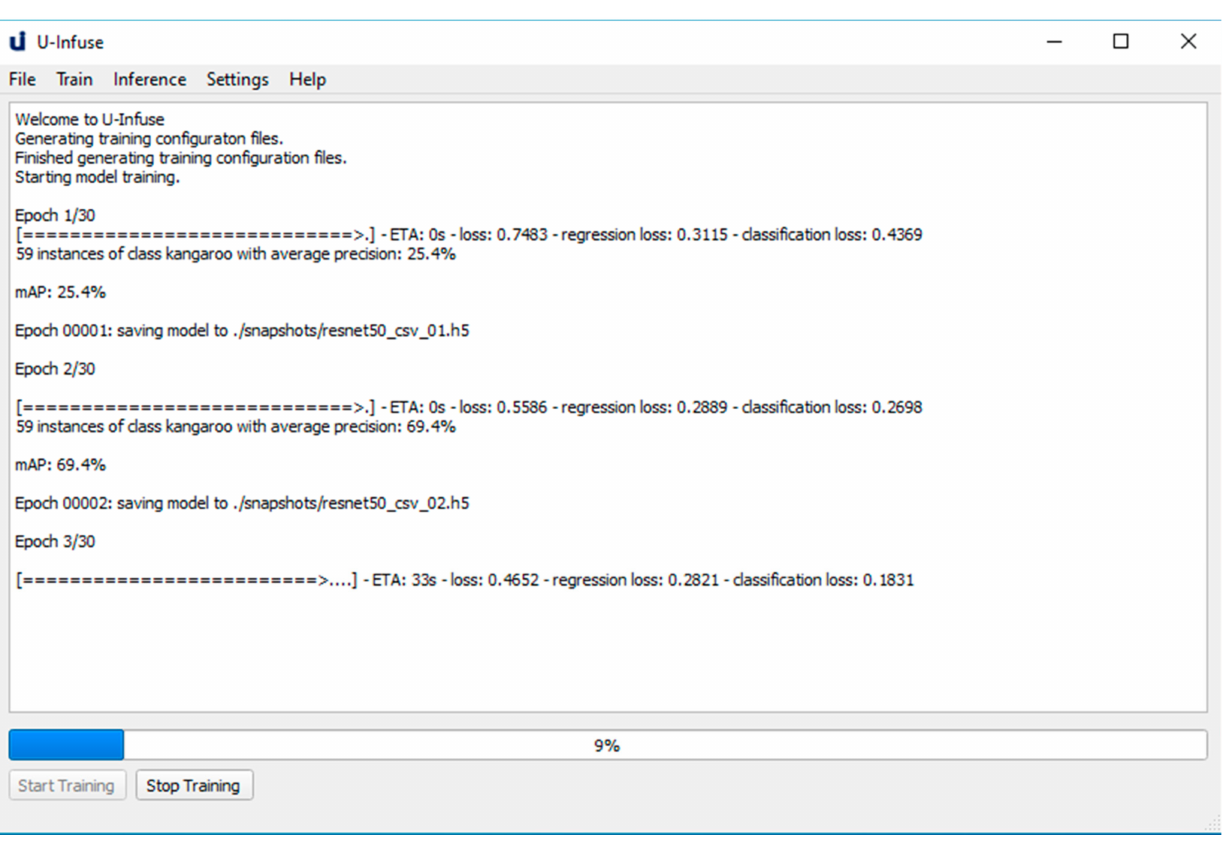
Figure 7. The main frame which allows users to start, stop and monitor training of custom models. Training progress can be monitored via the overall training loss, regression loss and classification loss. Generally, the lower the loss, the better the training. Model performance can also be monitored via the validation mAP, which is calculated on a subsample of the training